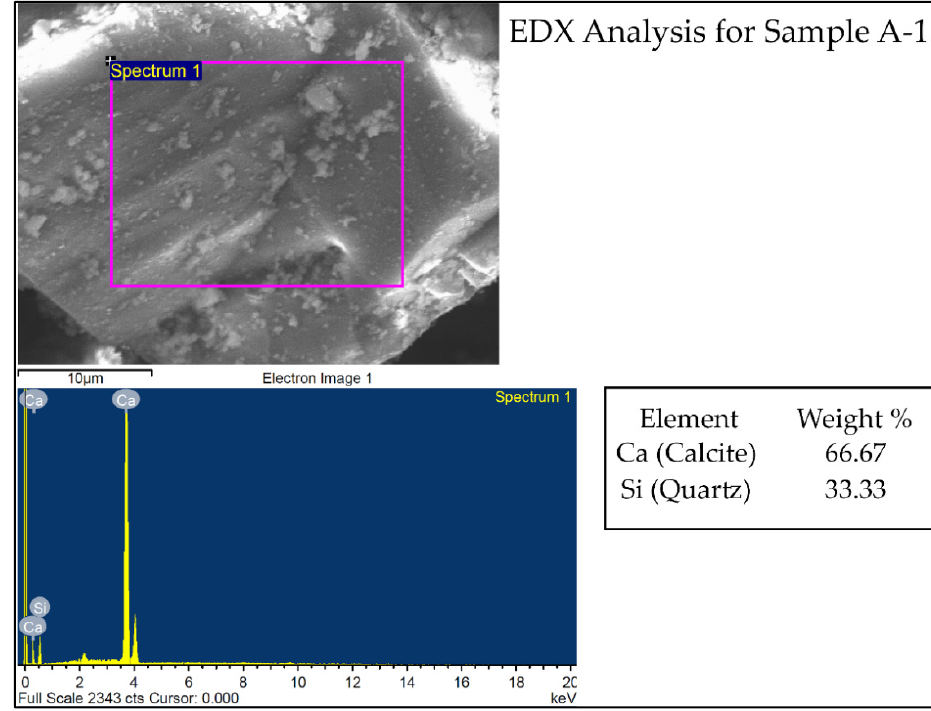
Figure 3. EDX analysis of sample A-1.3.